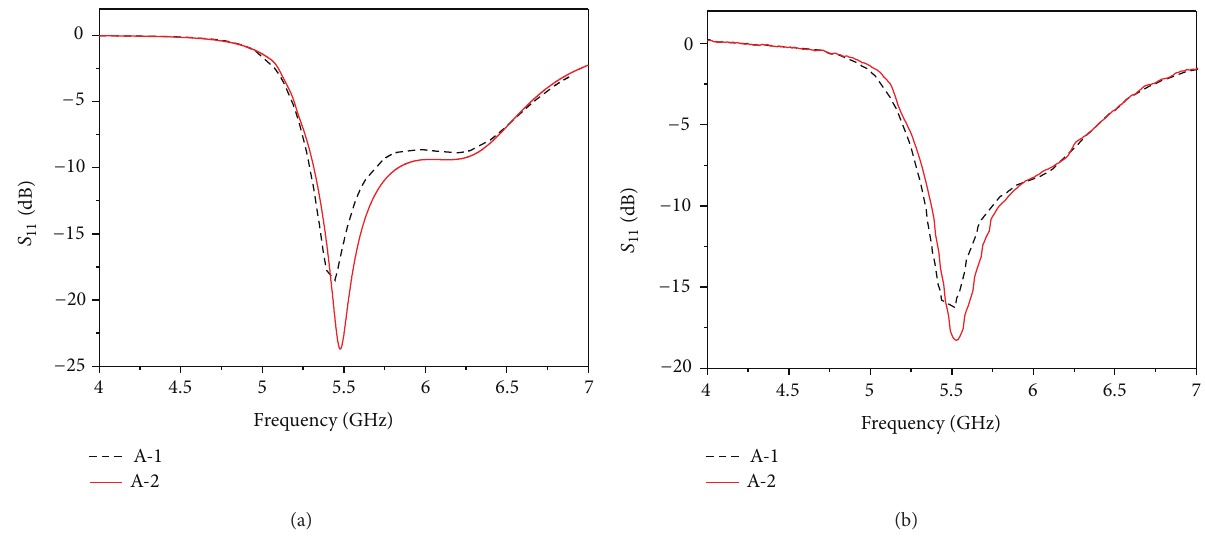
Figure 5: 𝑆 11 parameters of A-1 and A-2 (a) simulation and (b) measurement.